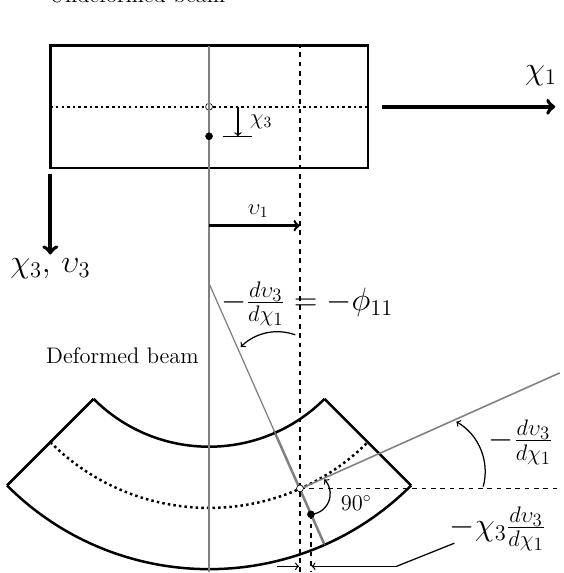
Figure 2. Strains, displacements and rotations of Euler–Bernoulli beam.